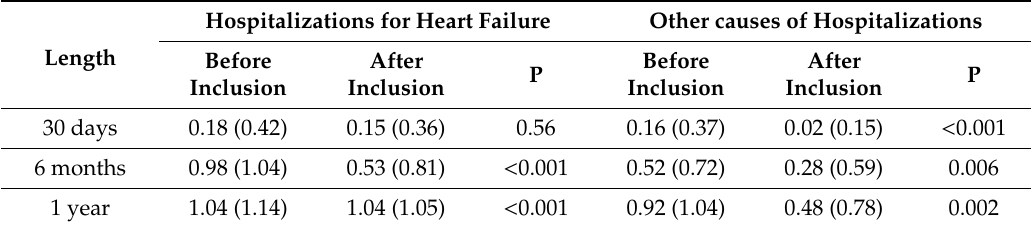
Table 3. Mean number of hospitalizations for heart failure before and after inclusion in the PRADO-IC program (at 30 days, 6 months, and one